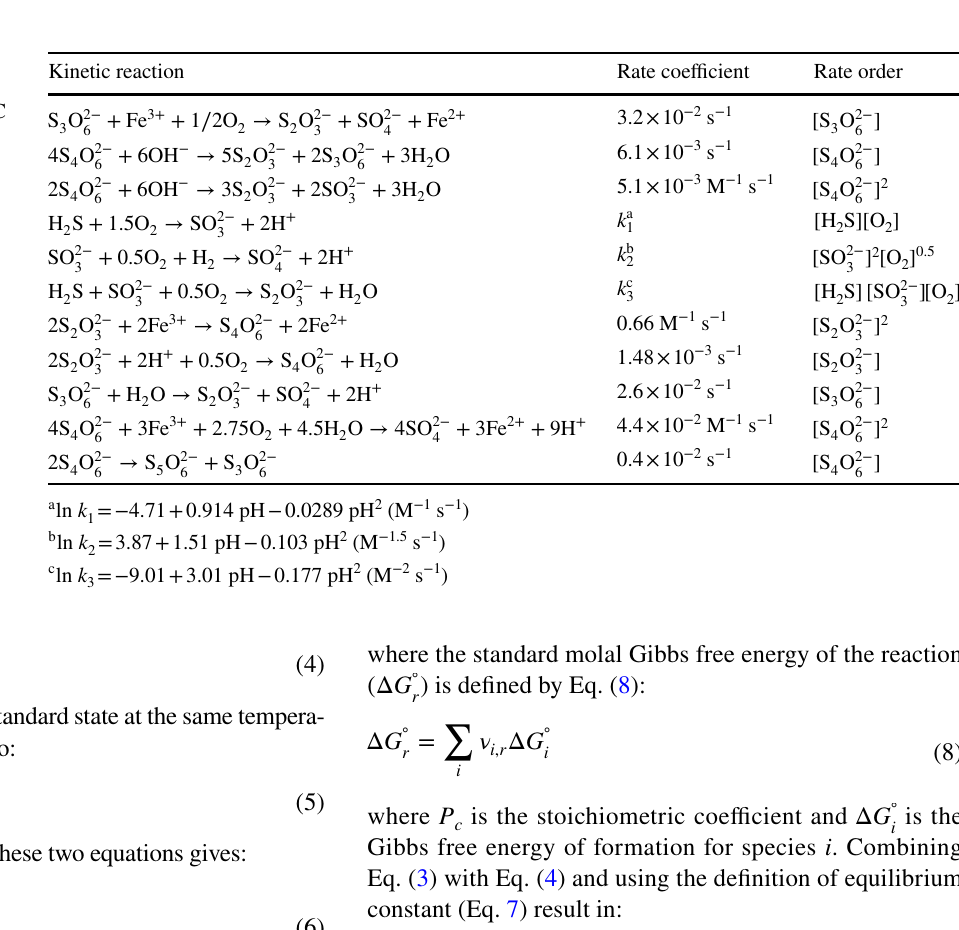
of sulfur-containing compounds considered in this study (Moses et al. 1987; Machel 1987; Zhang and Millero 1991, 1993; Heinen and Lauwers 1996; Wilkin and Barnes 1996; Lin et al. 2004; Zhao et al. 2007; TengShui et al. 2009; Zhang and Jeffrey 2010; Miranda-Trevino et al. 2013)